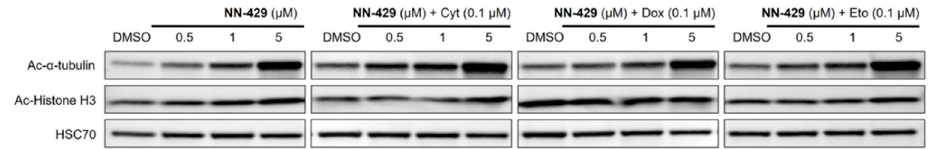
Figure 9. Western blot illustrating α -tubulin acetylation and histone H3 acetylation levels in YT cells following 24 h treatment with varying concentrations of NN-429, NN-429 + 0.1 µM cytarabine (cyt), NN-429 + 0.1 µM doxorubicin (dox), NN-429 + 0.1 µM etoposide (eto). Protein extracts were prepared, resolved by SDS-PAGE, and immunoblotted with acetylated α -tubulin, acetylated Histone H3 and HSC70 antibodies were used for loading controls. A representative Western blot of three independent experiments is shown.